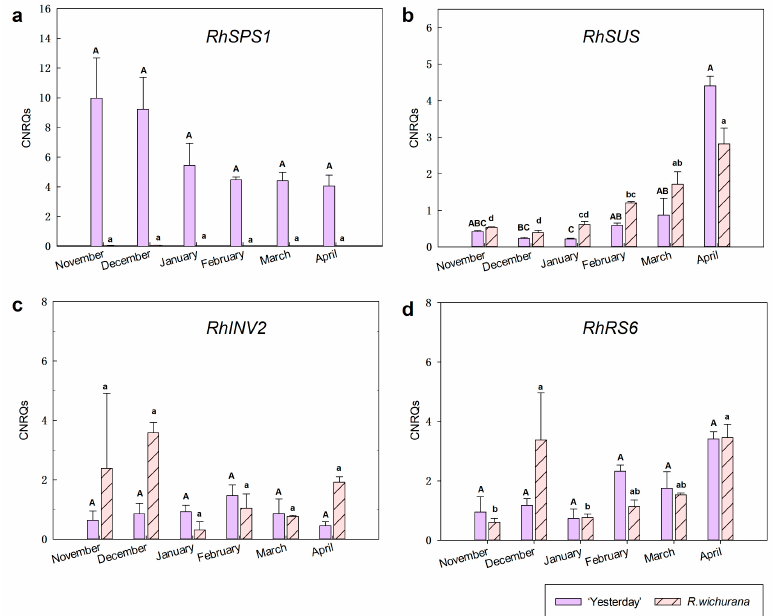
Figure 4. Seasonal changes in gene expression of RhSPS1 ( a ), RhSUS ( b ), and RhINV2 ( c ) in sucrose biosynthesis and RhRS6 ( d ) in RFOs (raffinose family oligosaccharides) biosynthesis in the more cold ‐ hardy genotype ( Rosa hybrida ‘Yesterday’) and the less cold ‐ hardy genotype ( R. wichurana ). Data were assessed by one ‐ way ANOVA and a Scheffé post ‐ hoc test ( p = 0.05) except for RhSUS of ‘Yesterday’ by the Kruskal–Wallis test ( p = 0.05). Different letters (A, B, etc.; or a, b, etc.) indicate significant differences between sampling time points within each genotype. Normalized relative quantities (CNRQs, non-log-transformed) are presented as geometric means ± SE ( n =